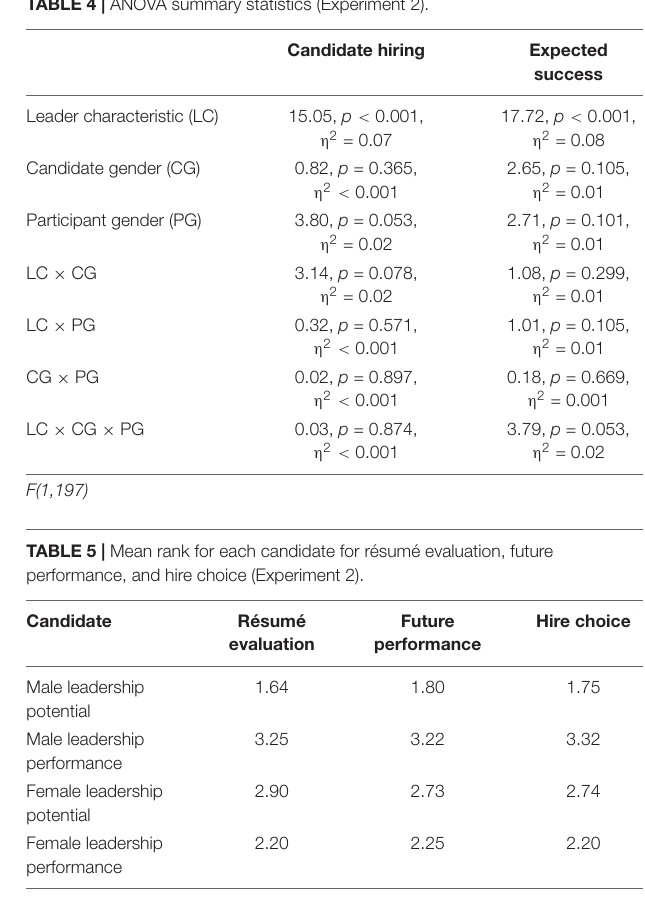
TABLE 4 | ANOVA summary statistics (Experiment 2).